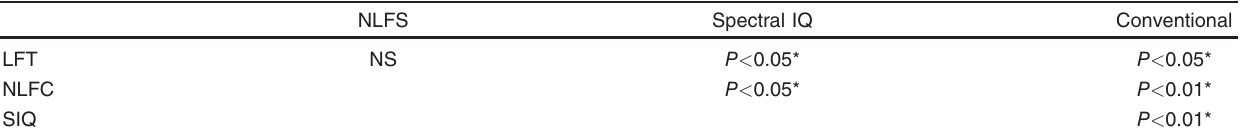
Table 8 Pairwise comparisons by Tukey honest significant difference test in aided speech word discrimination honest significant difference =